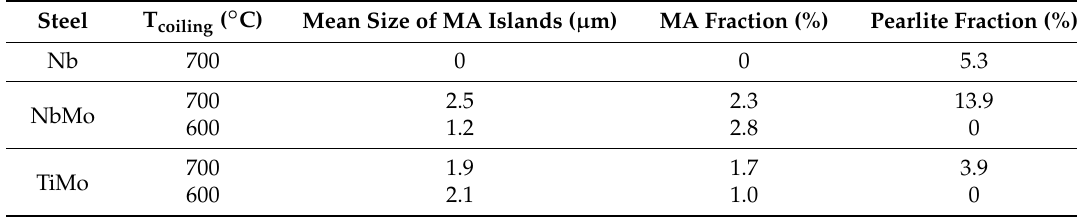
Table 2. Mean size of MA islands, MA fraction and pearlite fraction for each steel and coiling temperature. Steel T coiling ( ◦ C) Mean Size of MA Islands ( µ m) MA Fraction (%) Pearlite Fraction (%) Nb 700 0